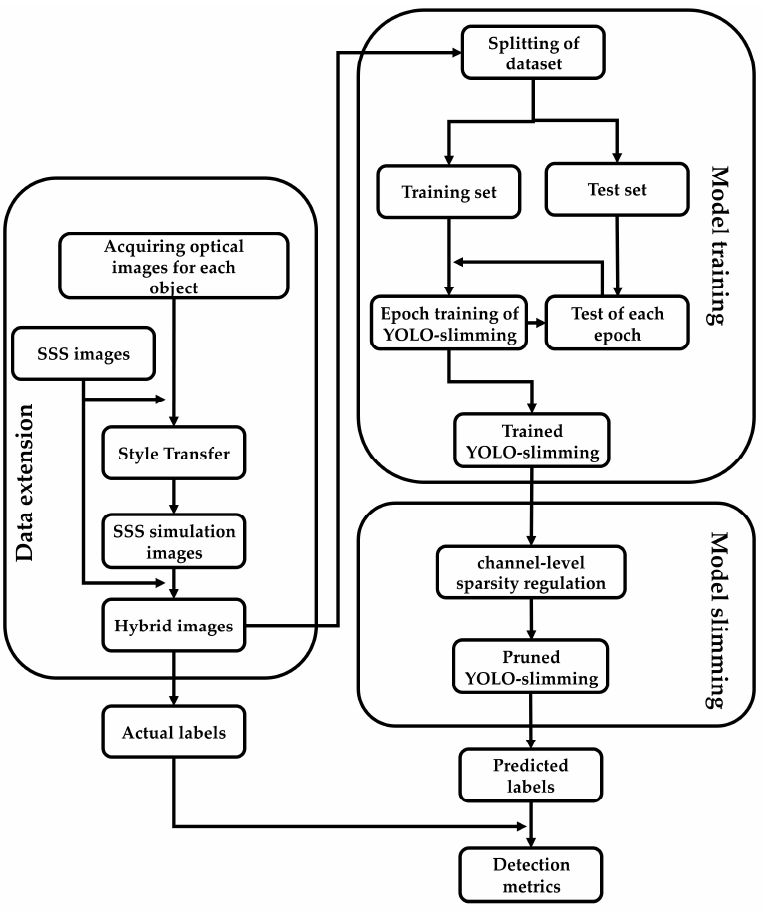
Figure 1. Workflow diagram of